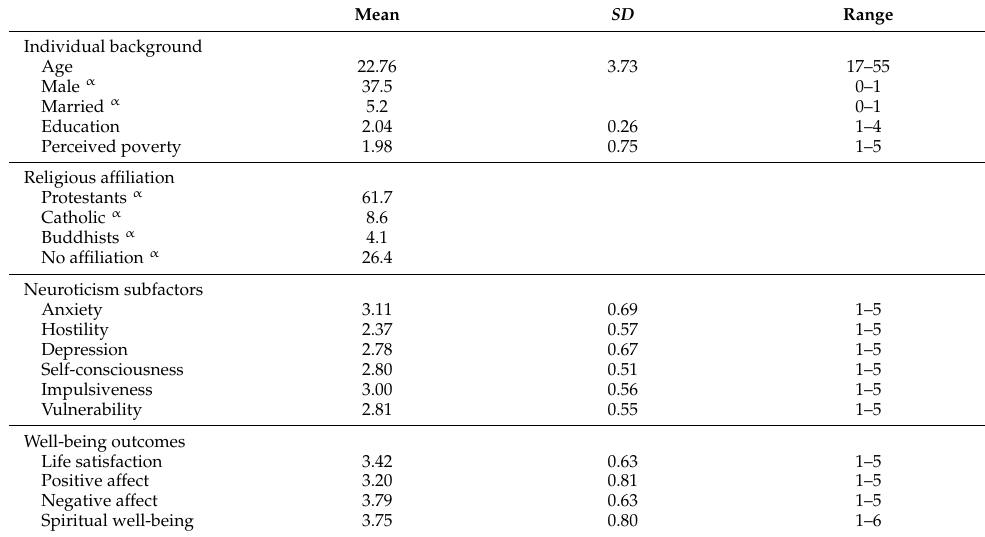
Table 1. Descriptive